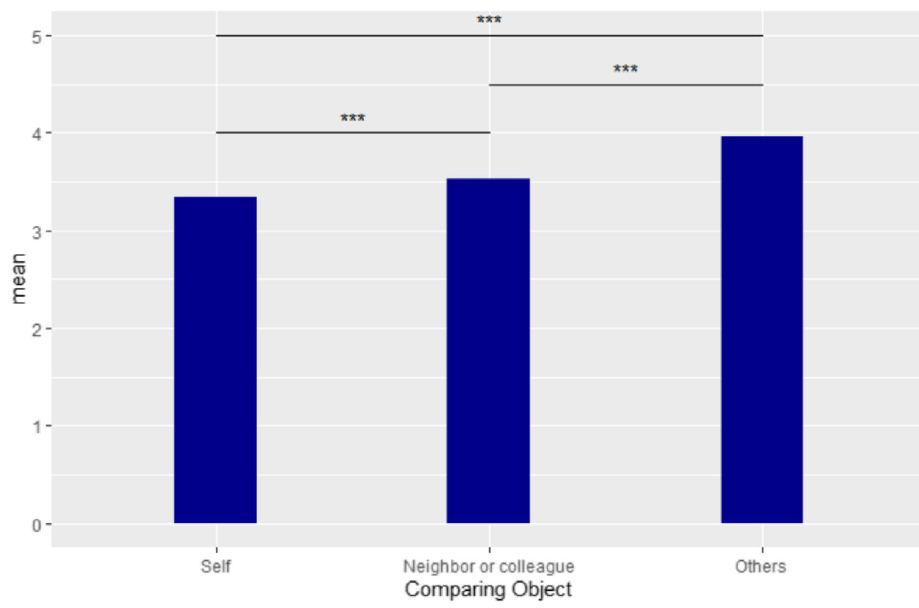
Figure 2. Optimistic bias scores. Note: *** p < .001.